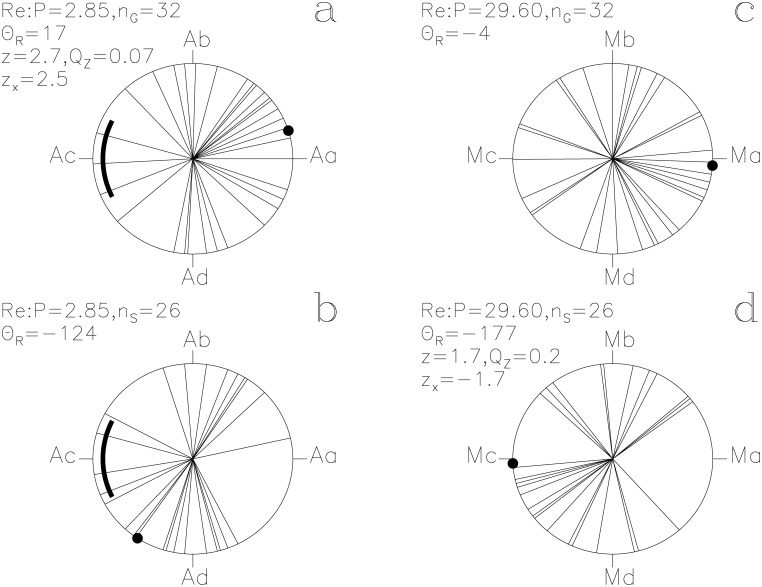
Re.otherwise as in Fig 1